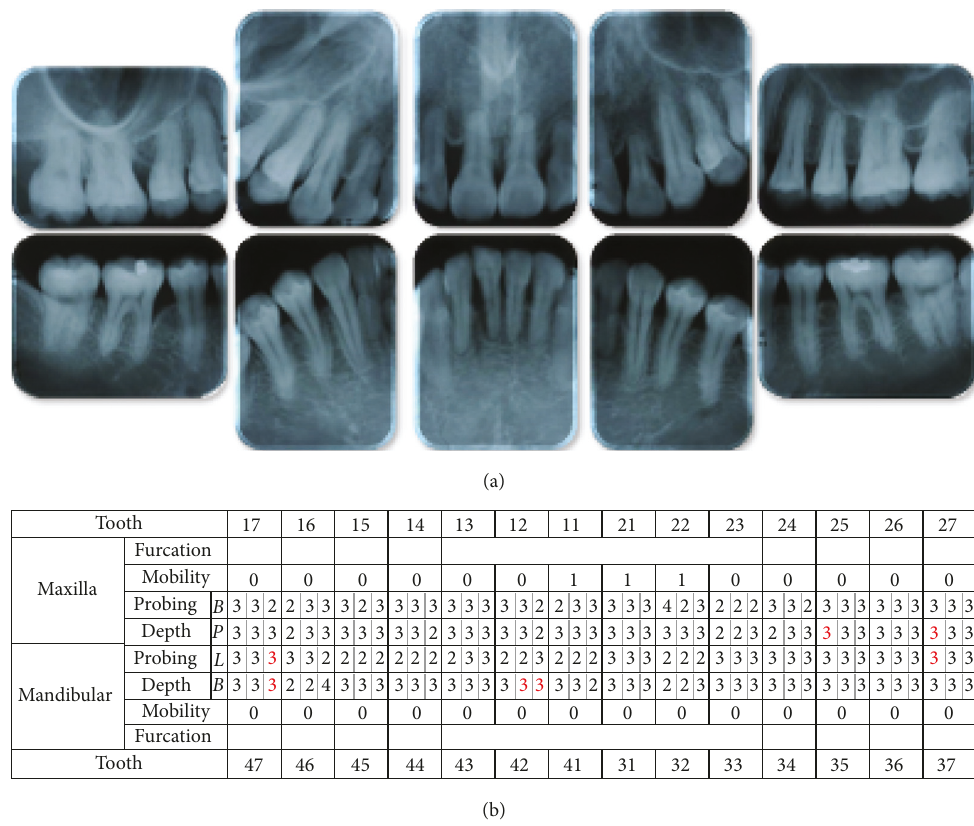
Figure 8: Post-orthodontic treatment dental radiographs (a) and periodontal examinations (b) are shown. The red color indicates bleeding on